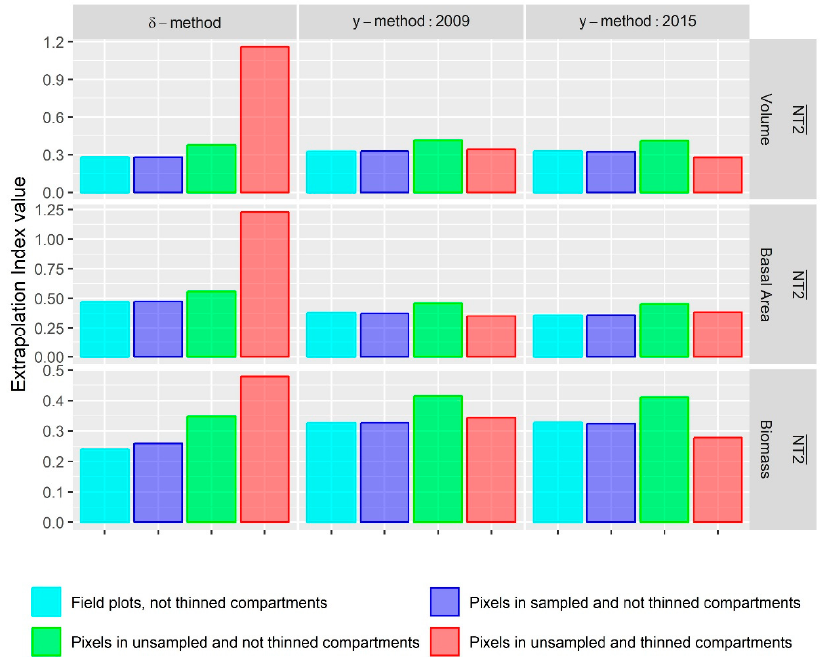
Figure 5. Indexes of extrapolation. Average of Mesgaran’s novelty index [35], NT 2, for the sampled and not thinned stands (dark blue), unsampled stands not thinned (green) and unsampled and thinned stands (red). The value of this index for the field plots (light blue) provides the baseline value (i.e., the value observed for the sample of field plots).